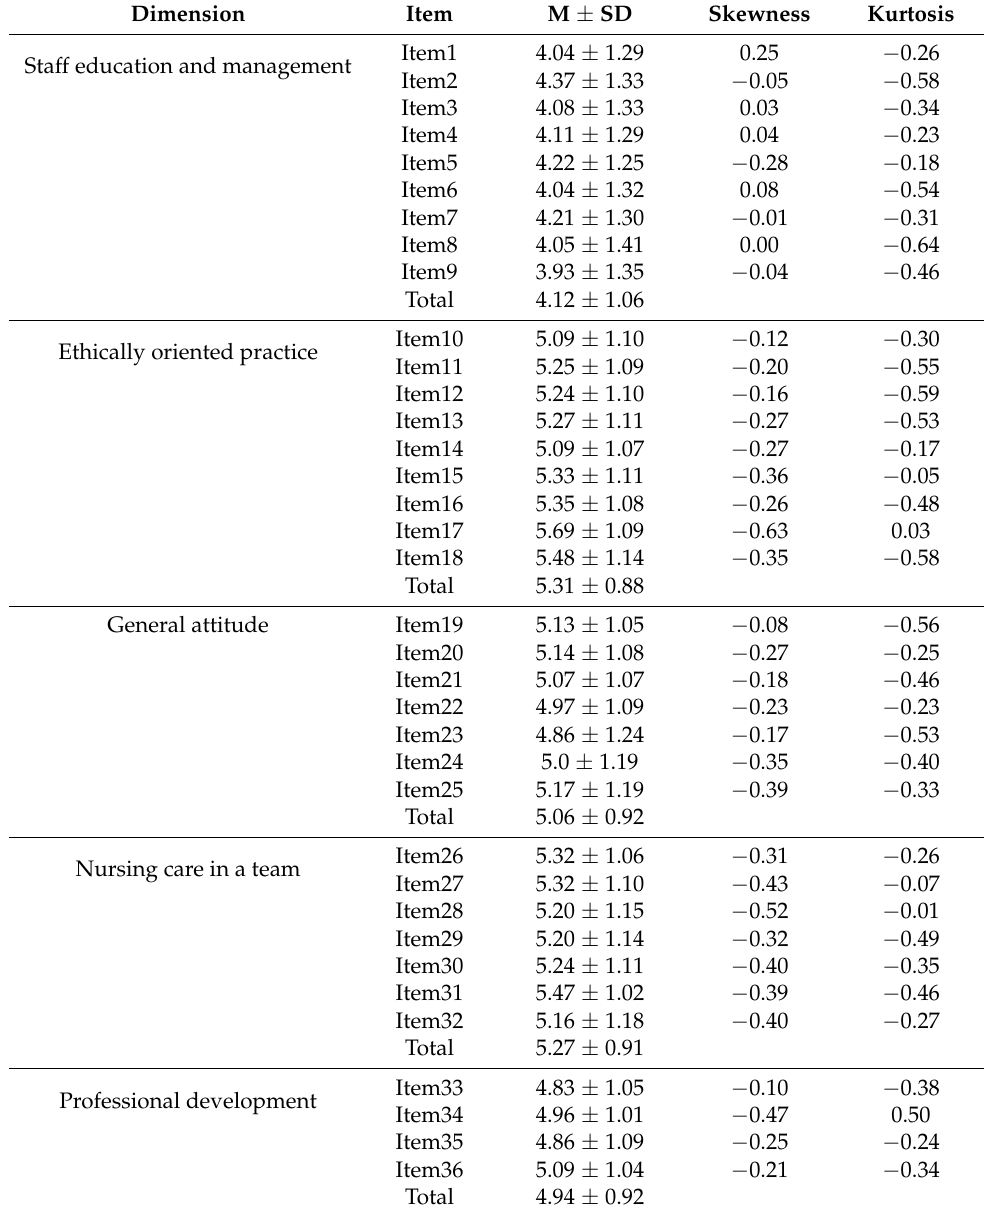
Table 2. Item analysis of HNCS (N = 251).